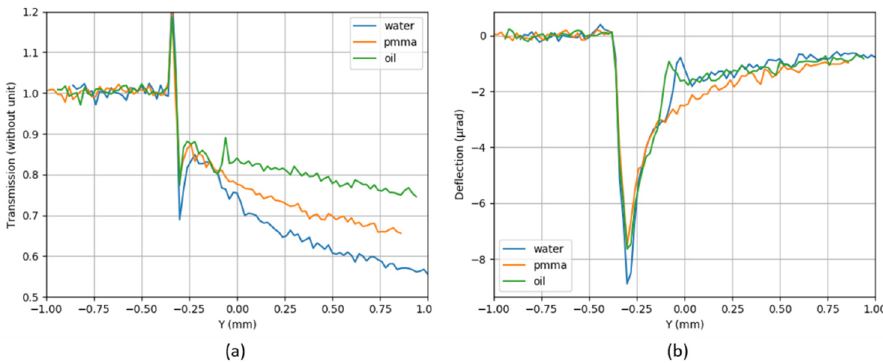
Figure 17. For the three samples (water in blue, PMMA in orange and oil in green): ( a ) average of the transmission map and ( b ) average of the deflection map along the Y direction.